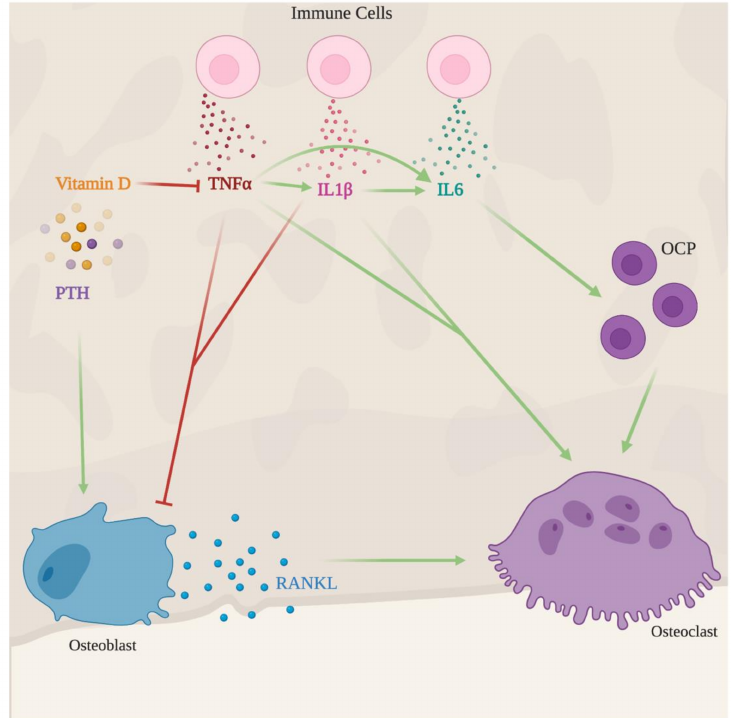
Figure 4. Indirect e ff ects of infection in the bone. Upon recognition of an invading pathogen, immune cells produce several immune mediators as IL1 β , TNF α , and IL6. These three cytokines promote osteoclastmaturationandactivity, hencefavoringboneresorption. IL1 β andTNF α furtherpromotebone loss by inhibiting new bone formation. Vitamin D and parathyroid hormone (PTH) counterbalance infection-induced bone loss. The former mediator decreases the production of pro-inflammatory cytokines such as TNF α , IL1 β and the latter hormone rescues osteoblast development and, thus, leads to new bone